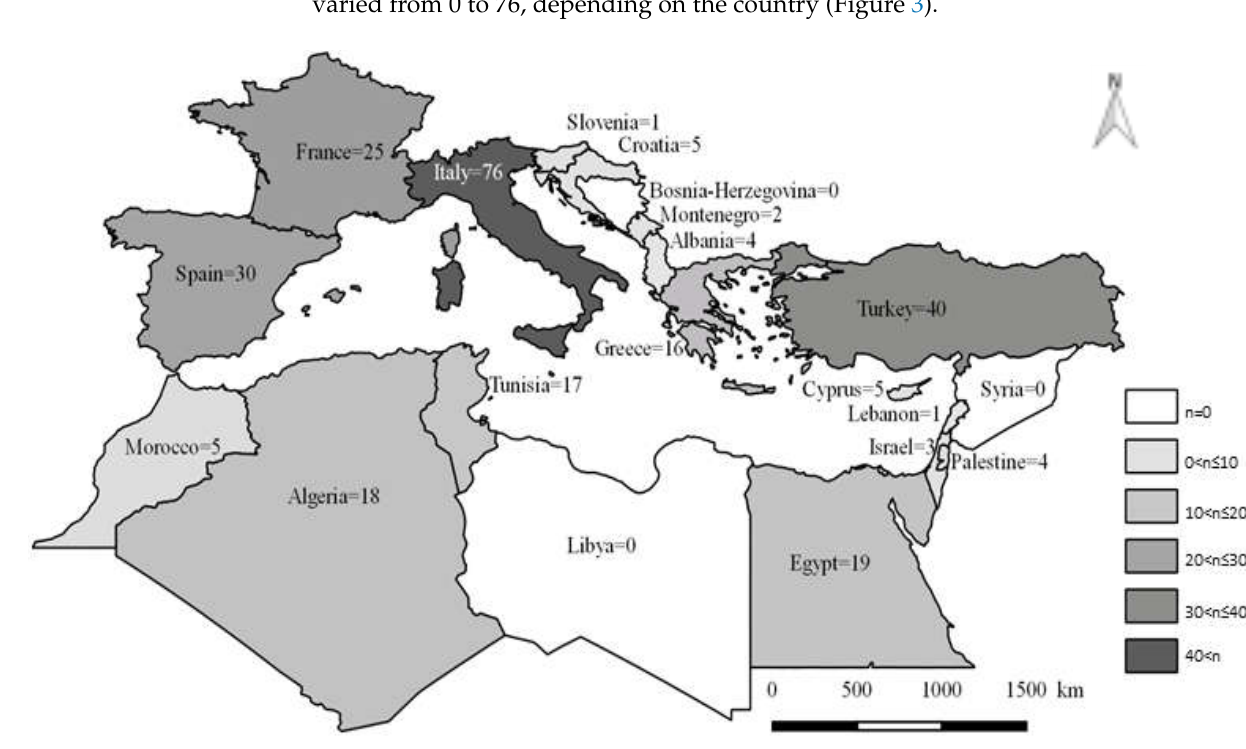
Figure 3. Number of publications dealing with TBPs in domestic animals and their ticks in the Mediterranean Basin according to country of origin .